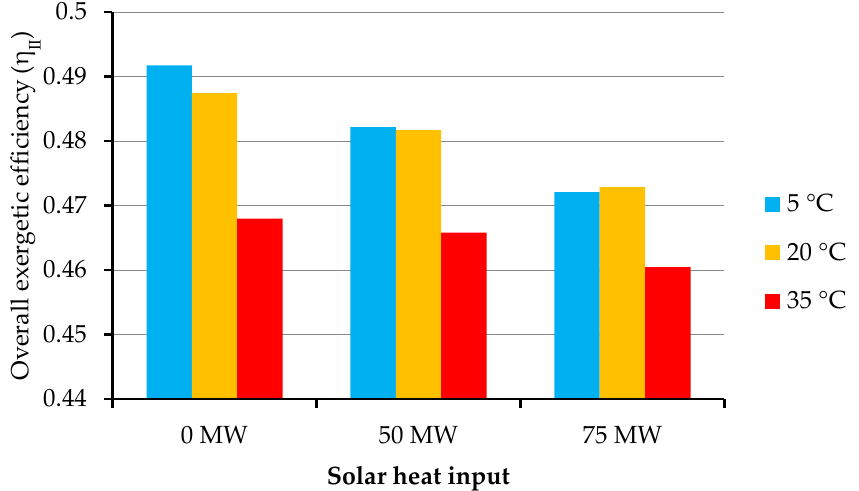
Figure 9. ISCC power plant exergetic efficiency at different ambient temperatures for different solar heat inputs.